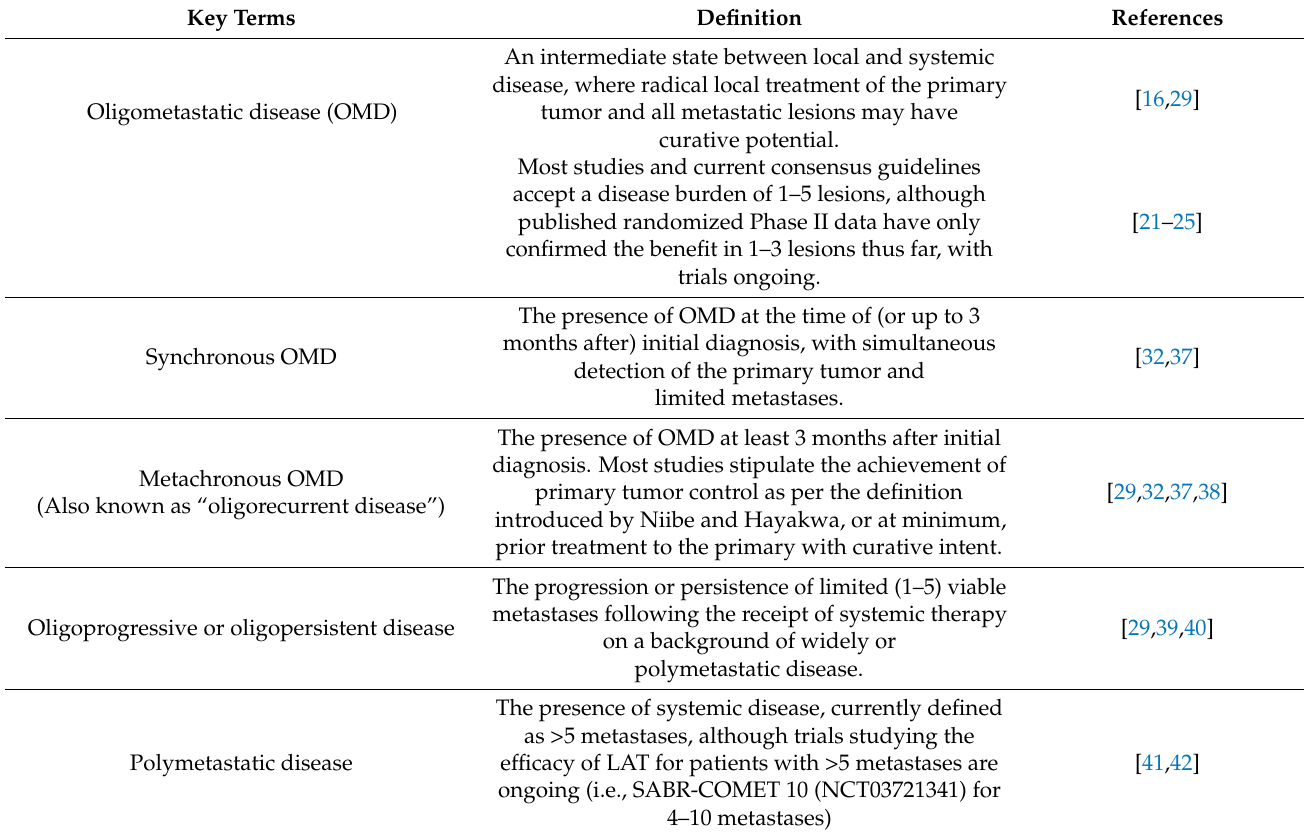
Table 1. Key definitions of the oligometastatic